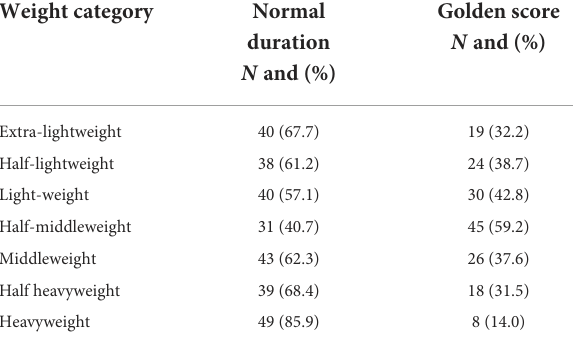
TABLE 3 Distribution of matches considering different durations (normal duration and the golden score) and match-variables